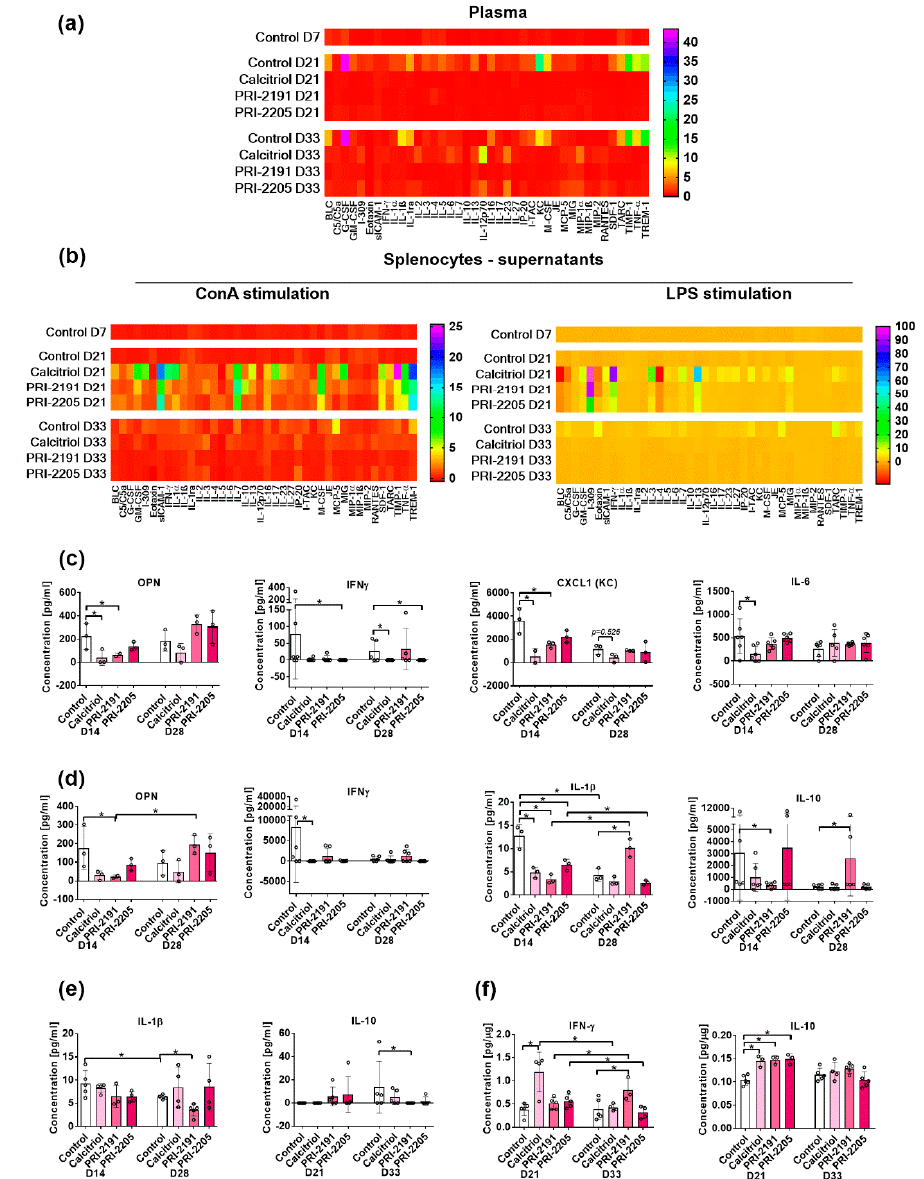
Figure 4. Analysis of cytokine arrays of plasma or supernatants from lipopolysaccharide (LPS)- /Concanavalin A (ConA)-stimulated splenocytes and expression of selected cytokines in tumor tissue. ( a , e ) Plasma; ( b – d ) supernatants obtained from spleen cells stimulated with LPS and ConA; ( f ) tumor tissue lysates. ( a , b )—samples analyzed with proteome profiler array. Samples from three randomly selected mice were pooled in each tested group. Data are presented as fold change as compared with healthy (D0) mice samples; ( c , d ) supernatants obtained from spleen cells (harvested on days 14 and 28) stimulated with ( c ) LPS and ( d ) ConA; ( e ) plasma from mice harvested on days 14 or 21 and 28 or 33; ( f ) tumors harvested on days 21 and 33, homogenized and lysed. ( c – f ) samples were analyzed with ELISA tests. Number of samples analyzed were 2–6 per group. Data are presented as mean ± SD and individual sample results. Statistical analysis: Kruskal–Wallis multiple comparison test. * p < 0.05. OPN—osteopontin; IFN- γ —interferon gamma; IL—interleukin; CXCL-1—chemokine (C–X–C motif) ligand 1; G-CSF—granulocyte-colony stimulating factor; GM—granulocyte-macrophage; sICAM-1—soluble intercellular adhesion molecule-1; M-CSF—macrophage colony-stimulating factor; MCP-5—monocyte chemotactic protein 5; MIG—macrophage-induced gene; MIP—macrophage inflammatory protein; SDF-1—stromal cell-derived factor 1; TIMP-1—stromal cell-derived factor 1; TNF—tumor necrosis factor; TREM—triggering receptor expressed on myeloid cells.